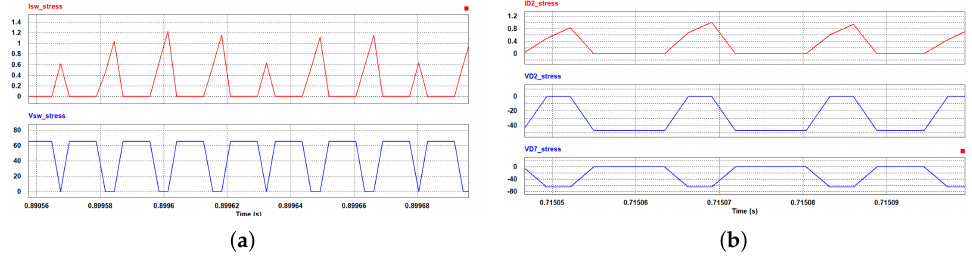
Figure 11. The voltage stress and current stress of important components: ( a ) the stress waveforms of switch Q ; ( b ) the stress waveforms of D 2 and D 7 .